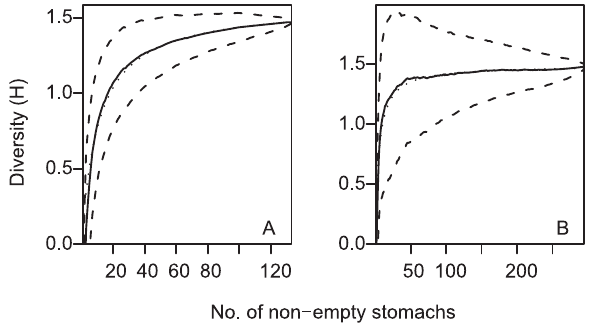
Figure 2. Cumulative diversity of prey categories (solid lines) and 95% credible intervals (broken lines) in the analyses of diet of a) Deaniacalcea , and b) Squalusacanthias . Dotted lines are the fitted curves from which asymptotic diversities were estimated.